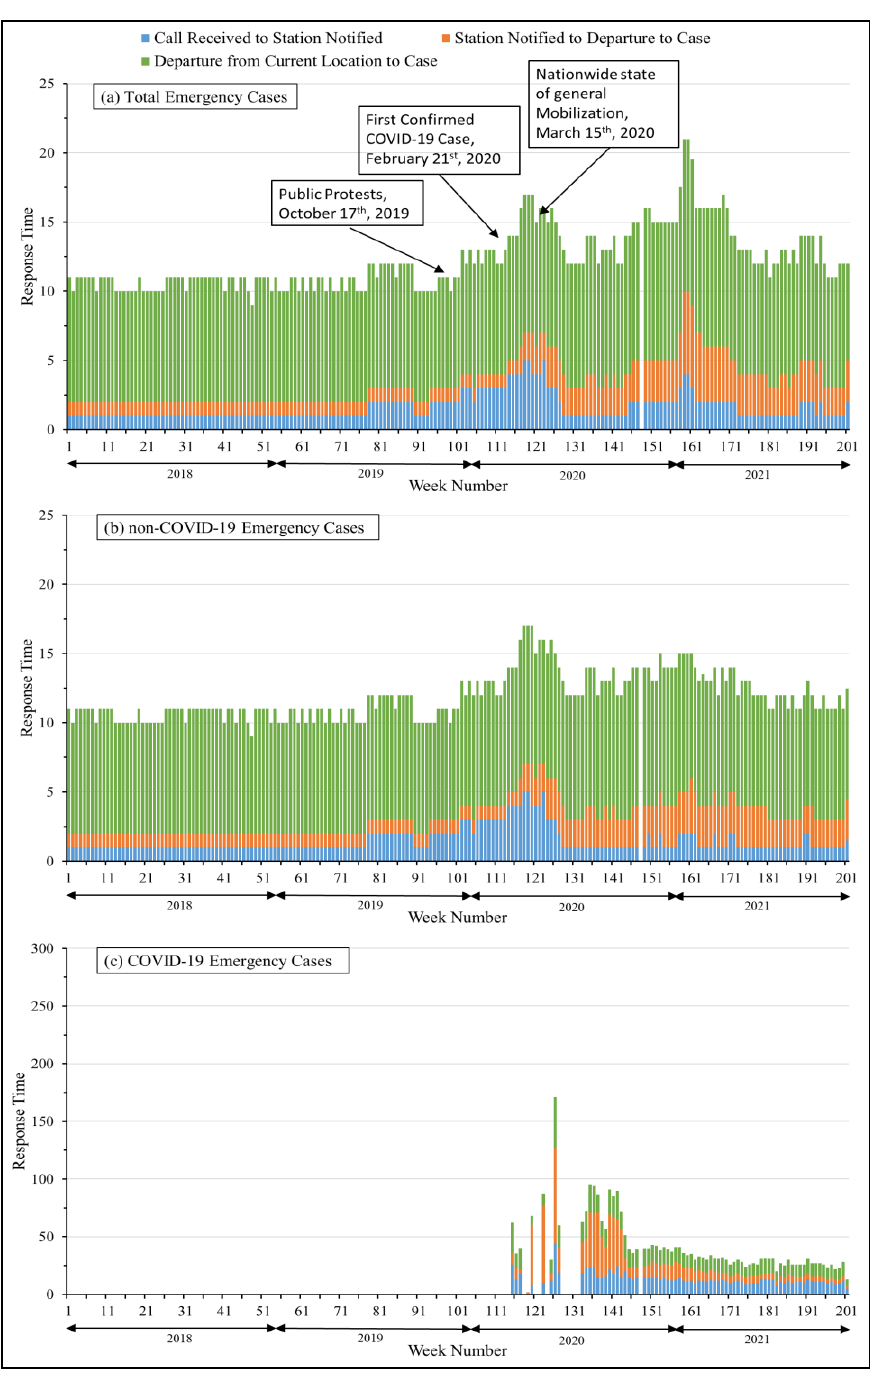
Fig. 9. Median of Segmented Weekly RT of Emergency Missions 2018-2021: (a) Total Emergency Missions; (b) non-COVID-19 Emergency Missions; (c) COVID-19 Emergency